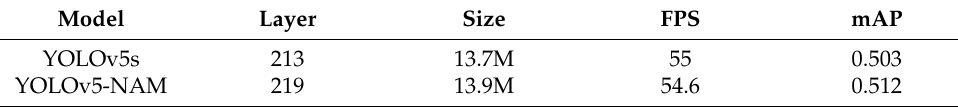
Table 1. The influence of network structure.